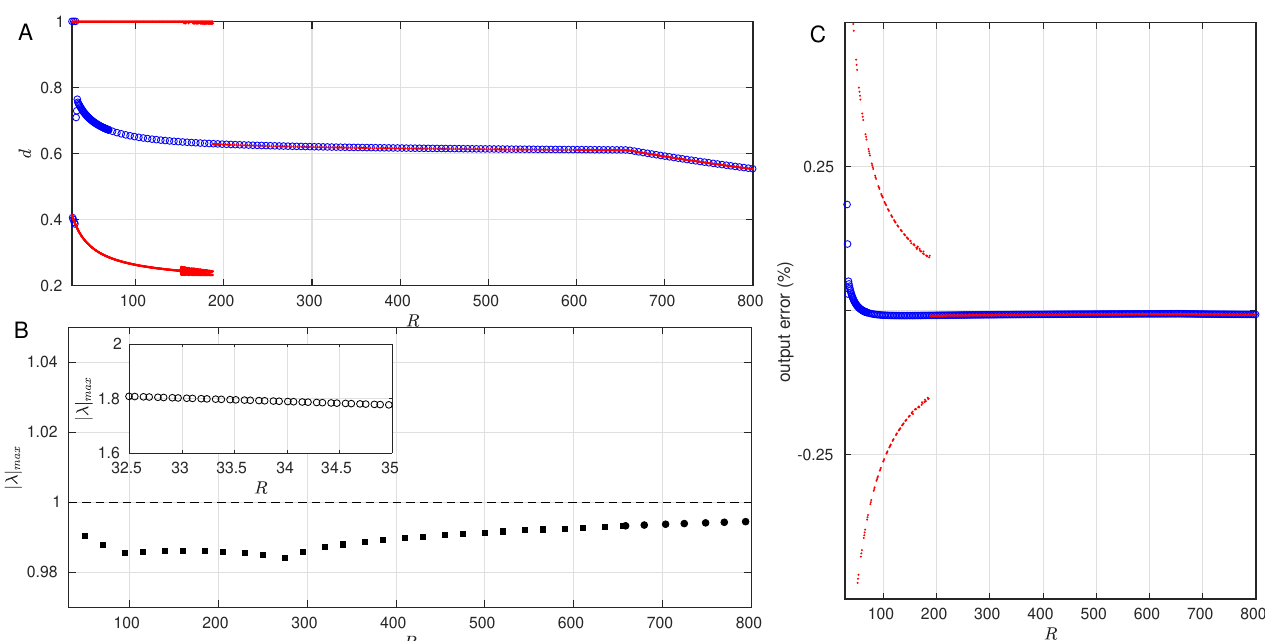
Figure 6. Bifurcations with R as a control parameter. ( A ). Duty cycle solution (11) in steady state with two protocols: Red (blue) line corresponds to increasing (decreasing) variations of the parameter. ( B ). Maximum Floquet multiplier of the period-1 orbits found in the studied interval. Solid (empty) symbols refer to stable (unstable) orbits. ( C ). Output error of the attractors of panel A, with the same color code. The parameters of this simulation, as in Table